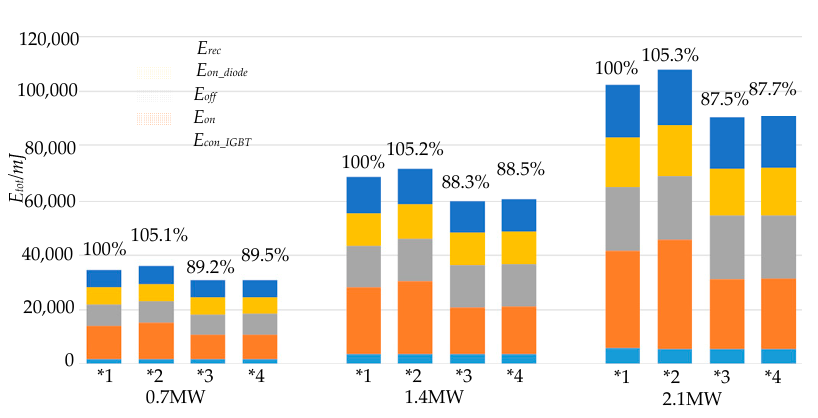
Figure 12. Total loss comparison between conventional IGBT and RC-IGBT at different loads. (Note: PWM